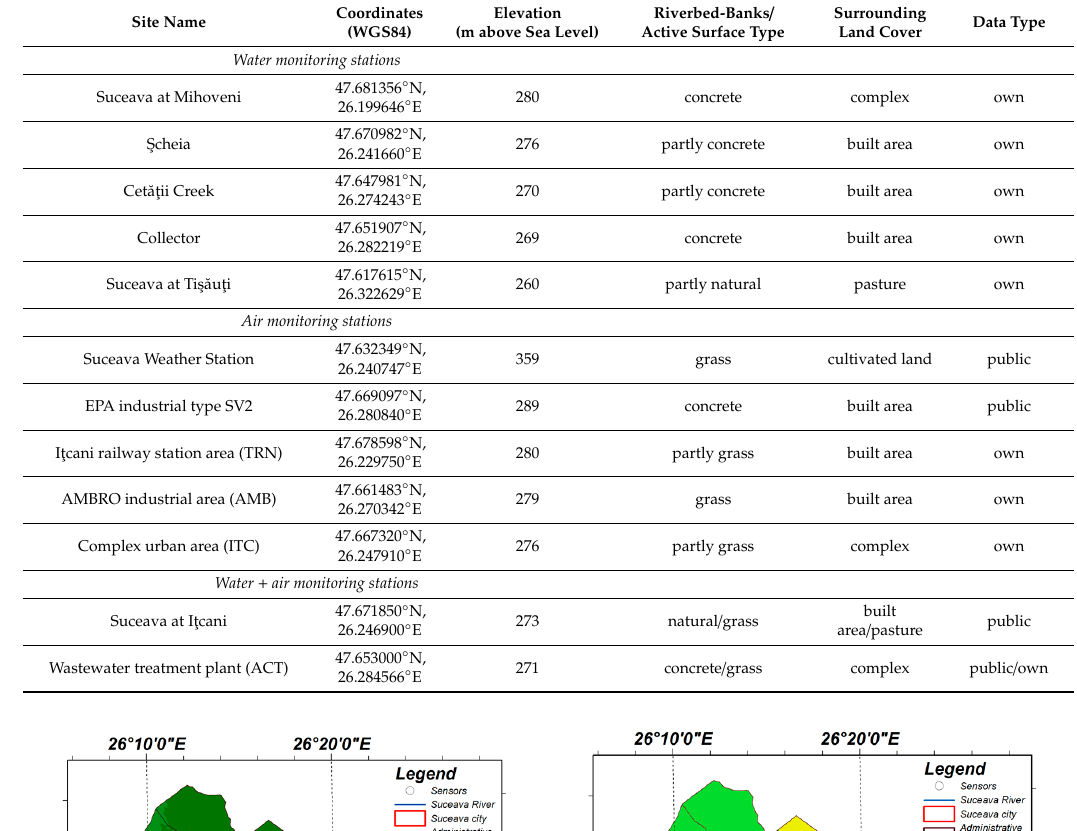
Table 1. Details of the monitoring stations used in this study.